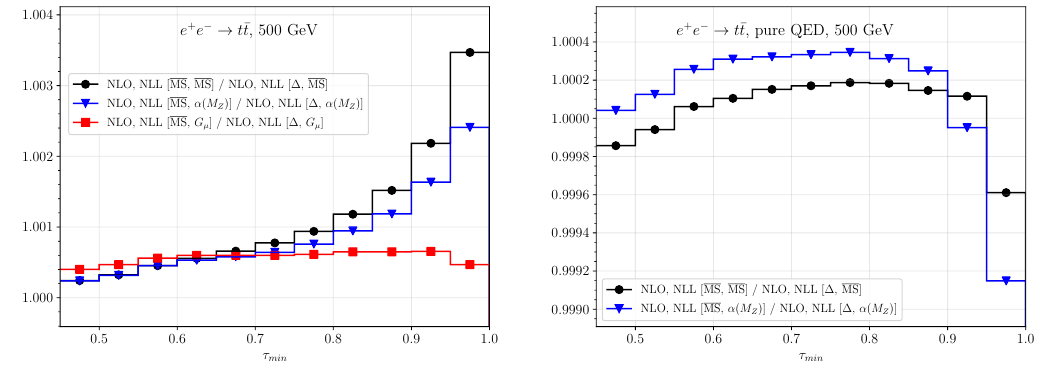
Figure 8 . As in figure 7, for t ¯ t production in the full SM (left panel) and in QED (right panel). in the MS ( ∆ ) factorisation scheme in the numerator (denominator). We do so separately for the three renormalisation schemes, i.e. MS (black curves overlaid with circles), α ( m ) Z (blue curves overlaid with triangles), and G (red curves overlaid with boxes). Thus, for µ any given colour/symbol, these histograms correspond to the ratios of the dashed over solid histograms with the same patterns that appear in figures 5 and 6. We conclude that the O (1) differences between different factorisation schemes observed in the